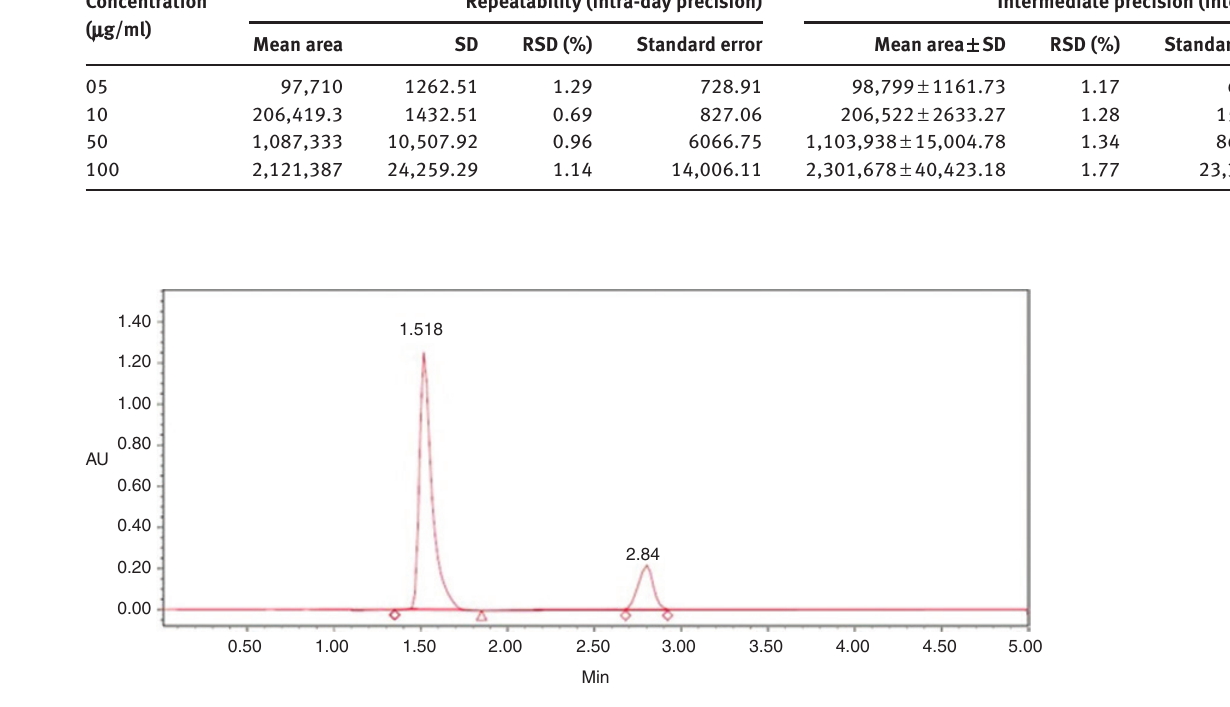
Figure 3: HPLC chromatogram of rosuvastatin in the presence of 0.1 m HCl.